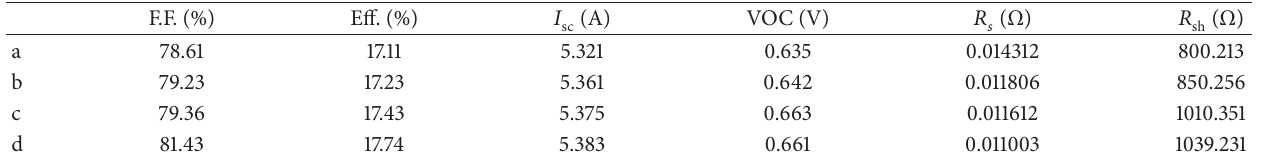
Table 1: Solar cell